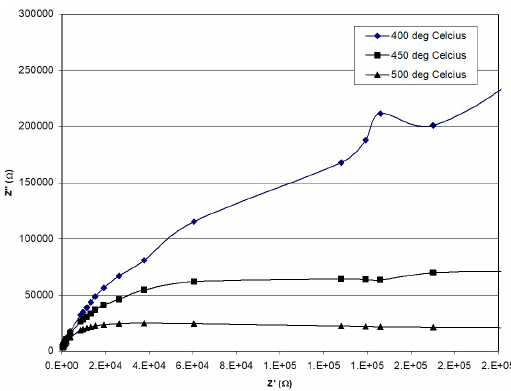
Figure 10. Complex impedance measured at 400,450 and 500 0 C in air of CSZ specimen containing 9 mol% CaO.